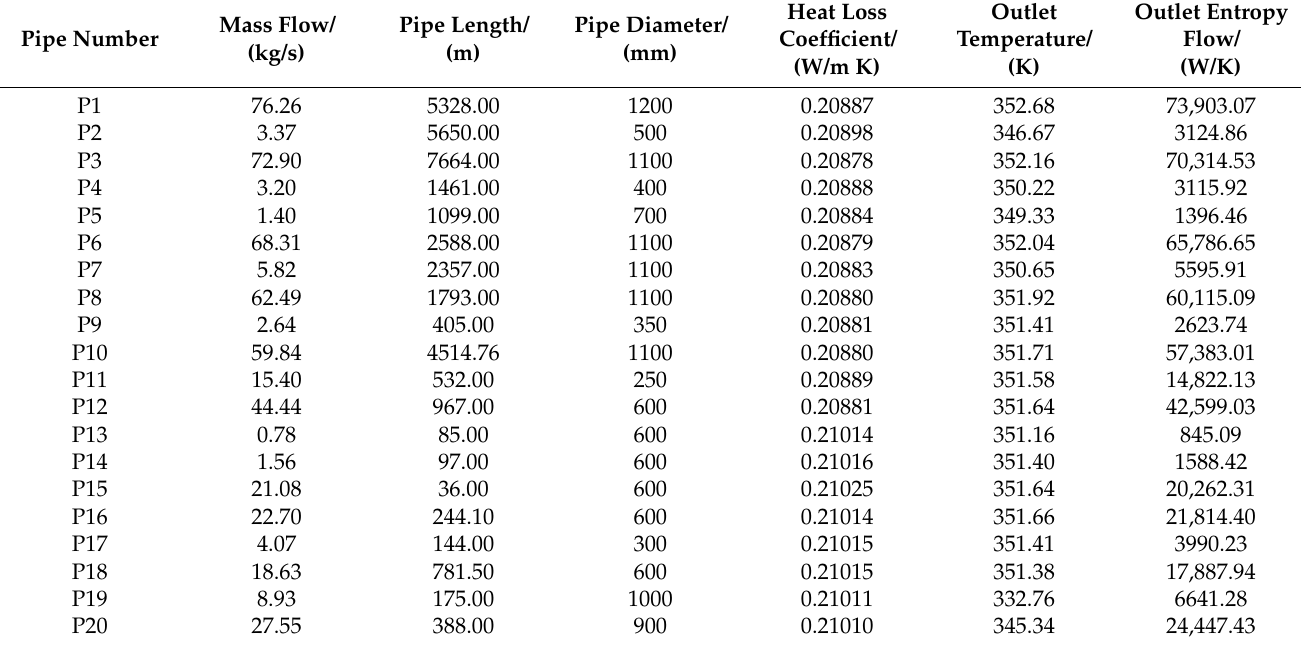
Table 3. Pipe parameters and calculation results of each branch in Case